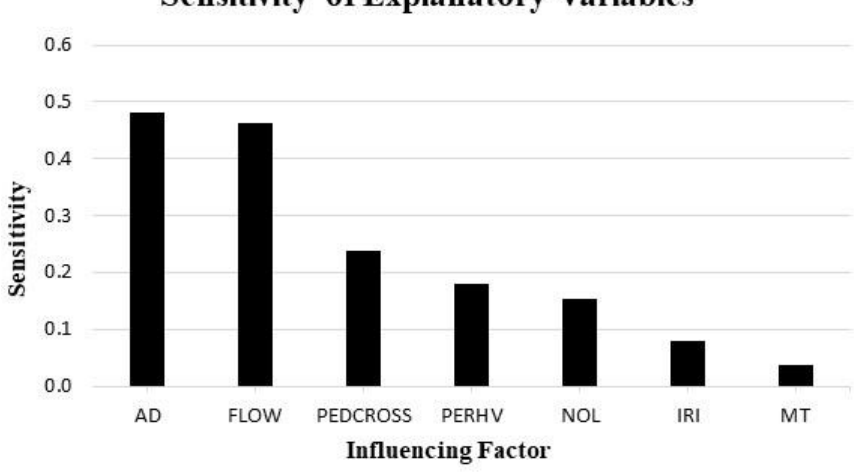
Figure 7. Sensitivity of Explanatory Variables.